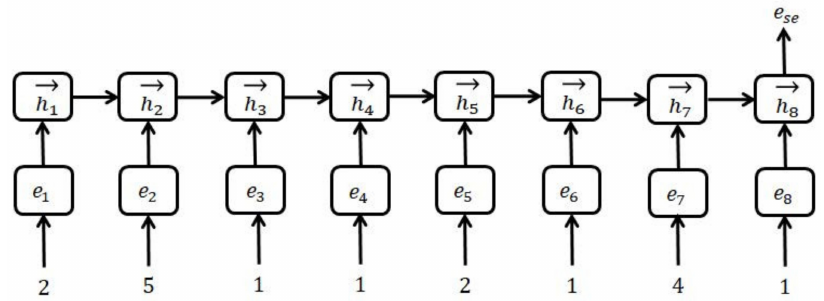
Figure 5. The stroke order feature generation of